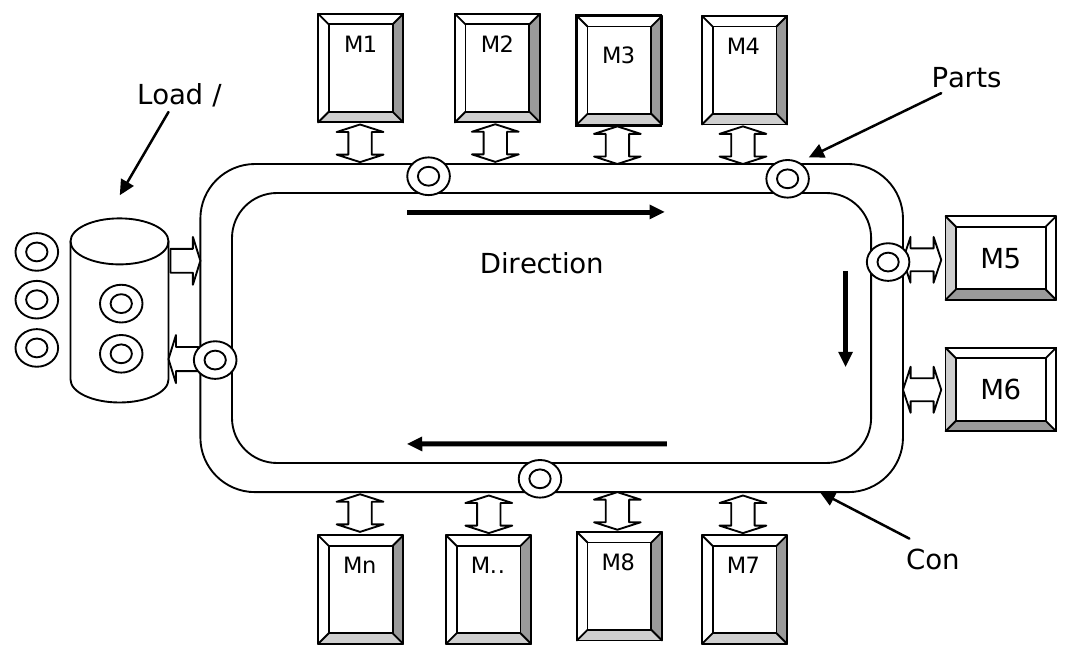
Figure 2. “Loop Layout configuration”. Source: Own